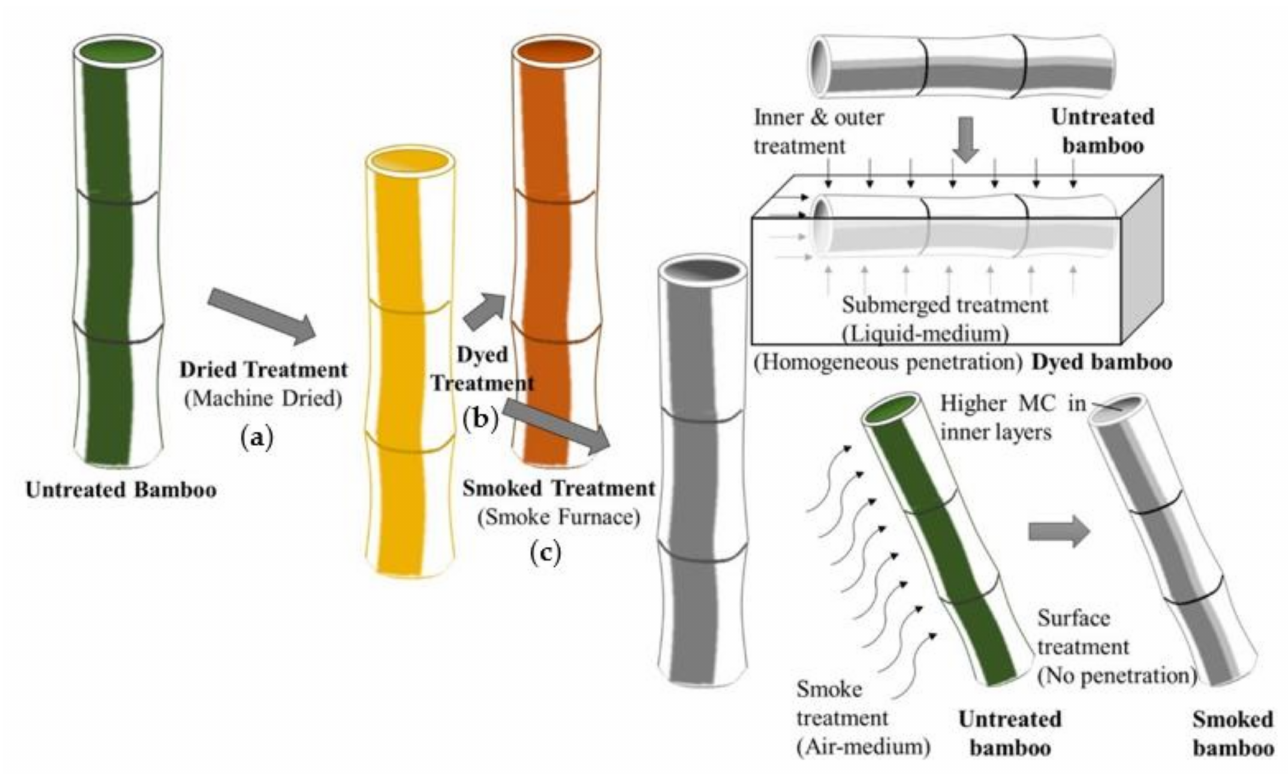
Figure 2. Schematic illustration of methodology of specimen preparation considered in this study; ( a ) dried treatment, ( b ) dyed treatment and ( c ) smoked